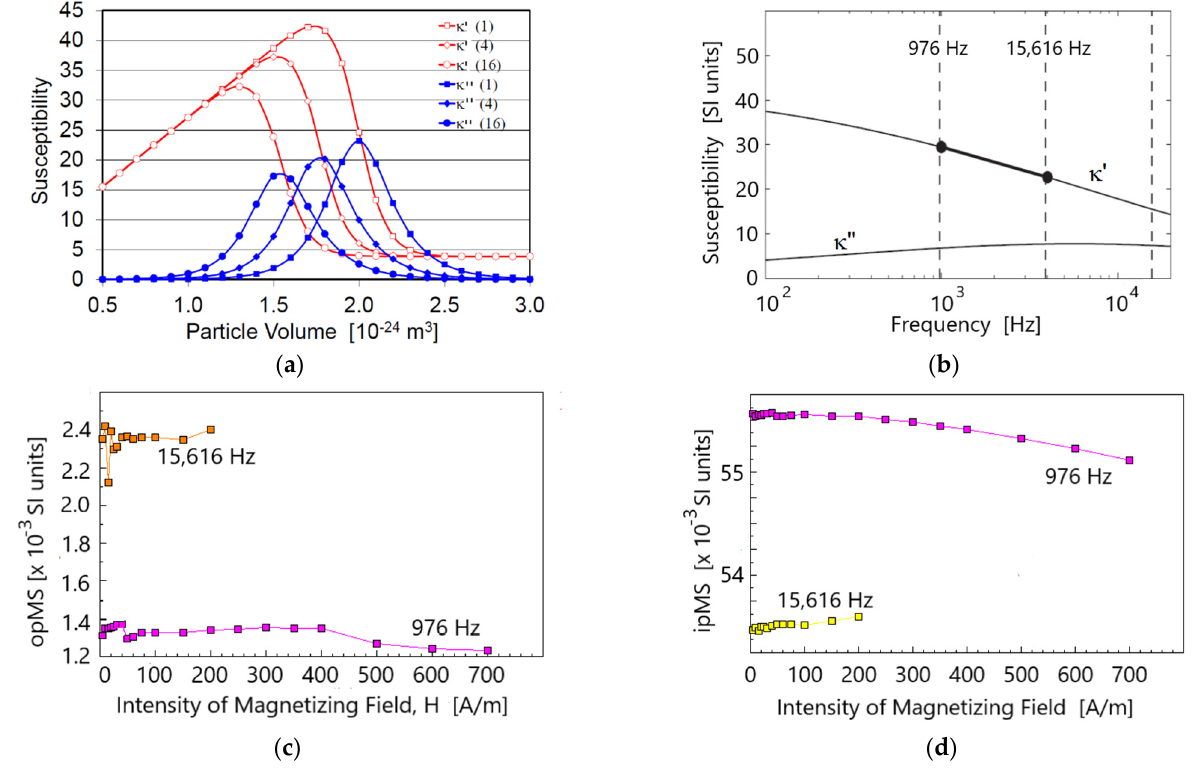
Figure 4. Theoretical ( a , b ) and experimental ( c , d ) variations of ipMS and opMS with magnetic particle volume and operating frequency. ( a ) Theoretical variations of ipMS ( κ ′ ) and opMS ( κ ″ ) for a single grain (in brackets are frequencies rounded to integers in kHz). ( b ) Theoretical variations of ipMS ( κ ′ ) and opMS ( κ ″ ) with operating frequency for a population of magnetic particles showing lognormal distribution of particle volumes (for details see the text). Two full circles on the κ ′ curve correspond to 976 and 15,616 Hz frequencies. Experimental field and frequency dependence of total (not corrected for volume) opMS ( c ) and ipMS ( d ) in a ferromagnetic liquid consisting of ultrafine magnetic particles in mineral oil. ( a , b ) adapted from [9]; ( c , d ) original measurements for this paper.